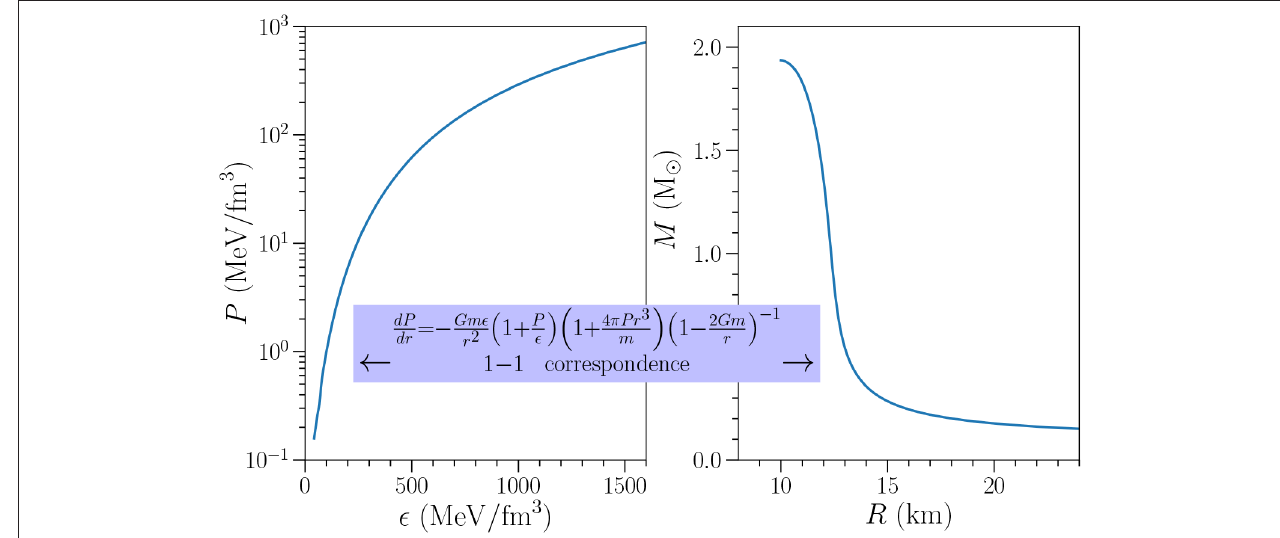
FIGURE 1 | The equation of state (left) and the resulting mass-radius relation (right) upon solving the TOV equations for an example equation of state, i.e., the Skyrme model “NRAPR” constructed in Steiner et al. [28] which was fit to the APR equation of state of Akmal et al. [29]. Republished with permission of IOP Publishing, from Gandolfi et al. [ 30]; permission conveyed through Copyright Clearance Center, Inc.